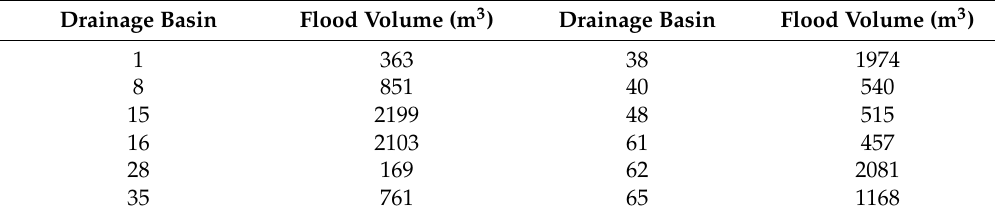
Table 1. Flood sources and flood volumes in the study area.